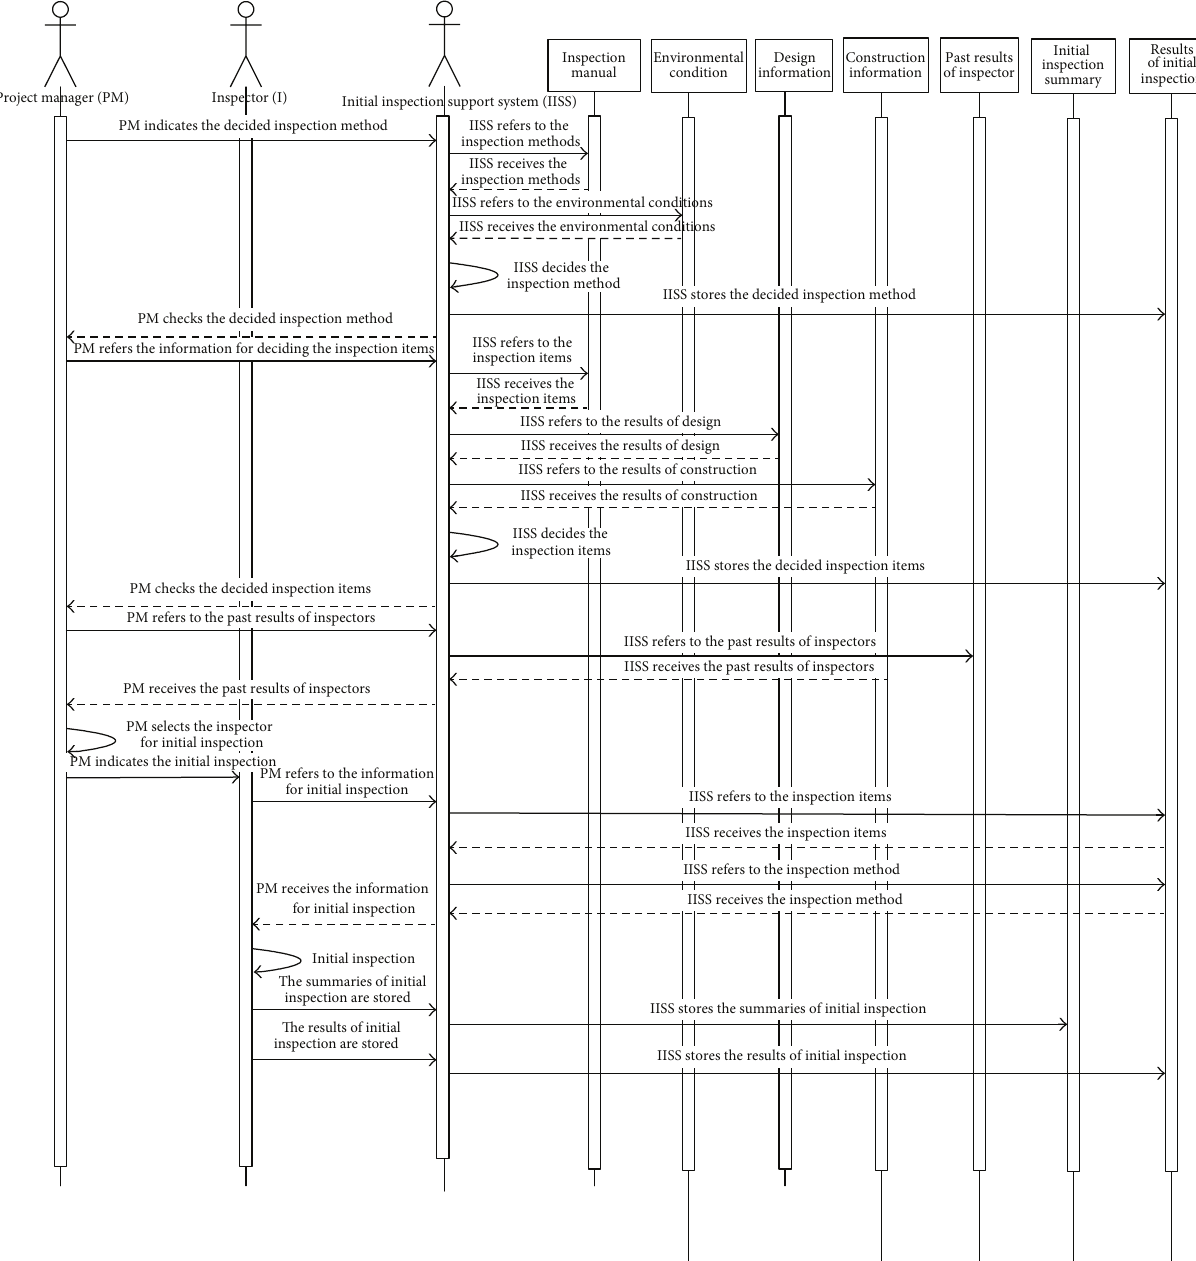
Figure 7: The utilization system of product data models in initial